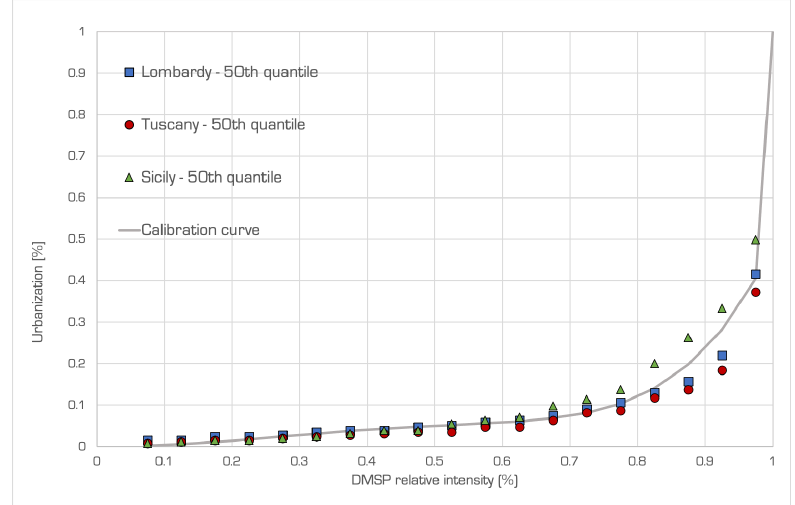
Figure 5. Visual comparison between 50th quantiles for the three calibration regions and the obtained fitting curve.